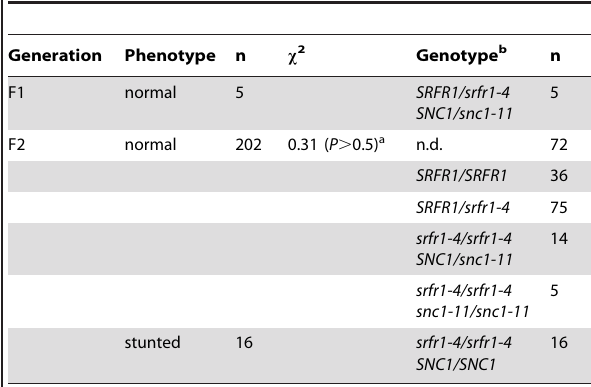
Table 4. Two copies of SNC1 are required for stunting in F2 plants from the cross snc1-11 6 srfr1-4 .